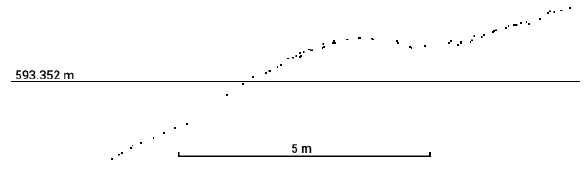
Figure 1. Example of wall (ridge) cross